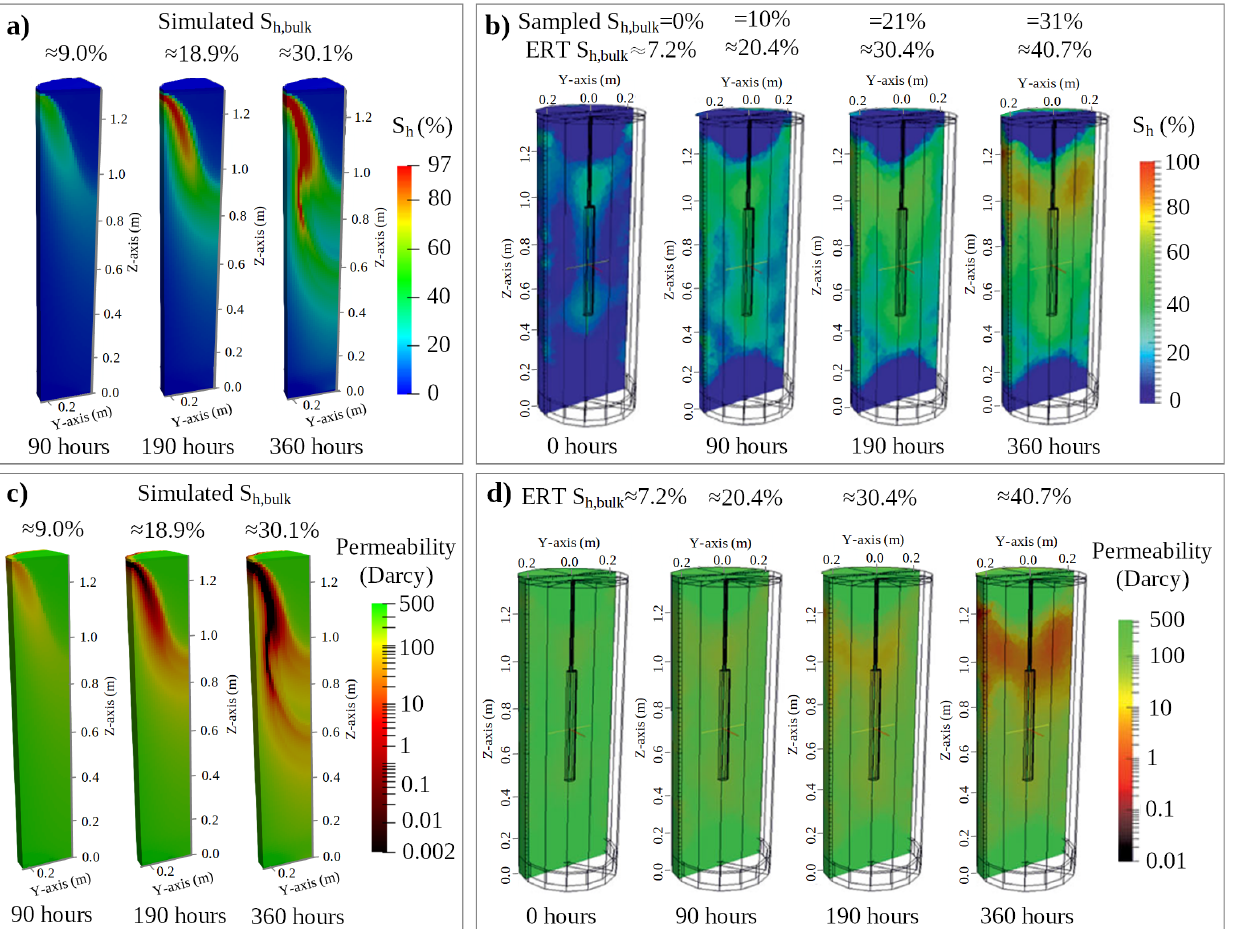
Figure 7. Numerical model validation by: (1) comparison of the simulated hydrate saturation (S h ) distributions ( a ) against those measured by ERT [27] ( b ) at experimental times of 0, 90, 190, and 360 h; (2) comparison of the temporal evolution of simulated S h,bulk ( a ) against the ERT-measured and pore fluid-sampled ones [27] ( b ) over selected experimental and simulation times; (3) comparison of the simulated spatial hydraulic permeability distributions ( c ) against ERT measurements ( d ) over selected experimental and simulation times, modified from Priegnitz et al.